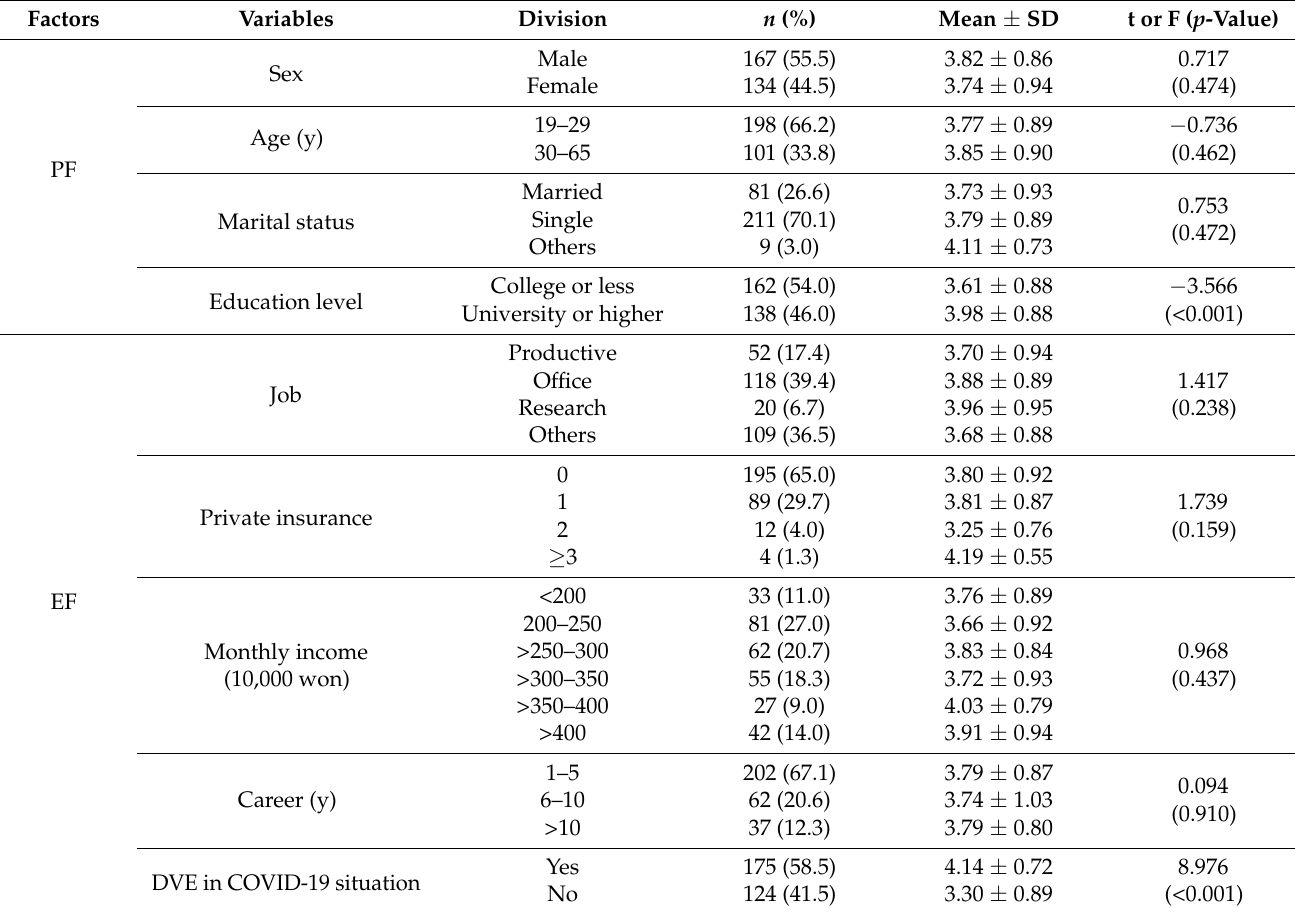
Table 1. Intention to use dental care according to the Anderson model among industrial